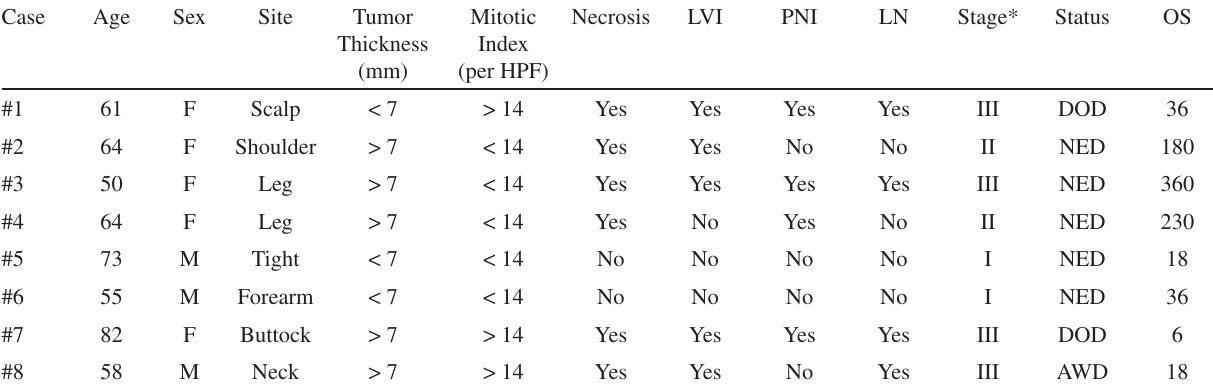
Table 2 - Clinical patterns from eight patients with a definitive eccrine porocarcinoma diagnosis.